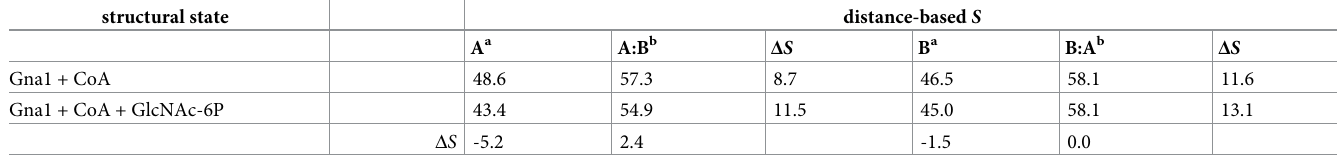
The s -scores are based on CCMpred DC scores, using the corresponding MSA from Table 2, on r = 2.6 Å and on m = 5. a The letters A and B correspond to the chain designations for the individual subunits; S in these columns is based solely on internal contacts. b S in these columns is based on internal and homodimeric contacts; the letter to the right of the colon represents the subunit from which trans-homodimer pairwise distances were obtained.